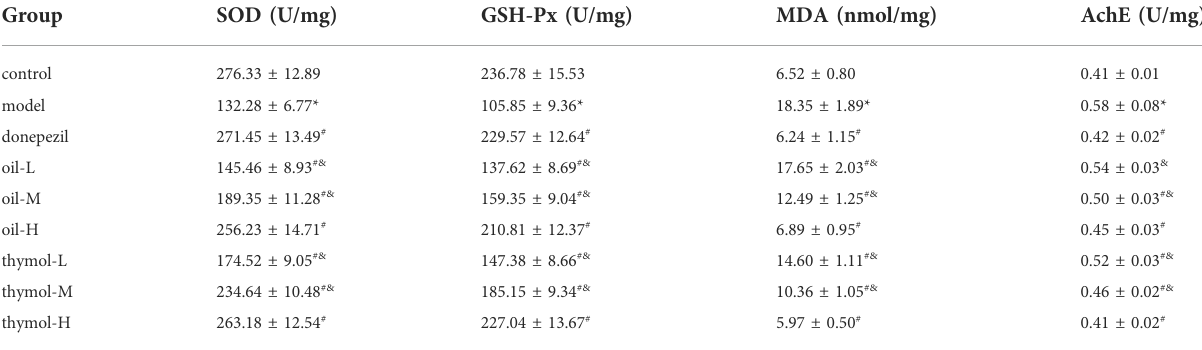
TABLE 2 Comparison of oxidative stress indexes and AchE activity in each group ( n = 5).